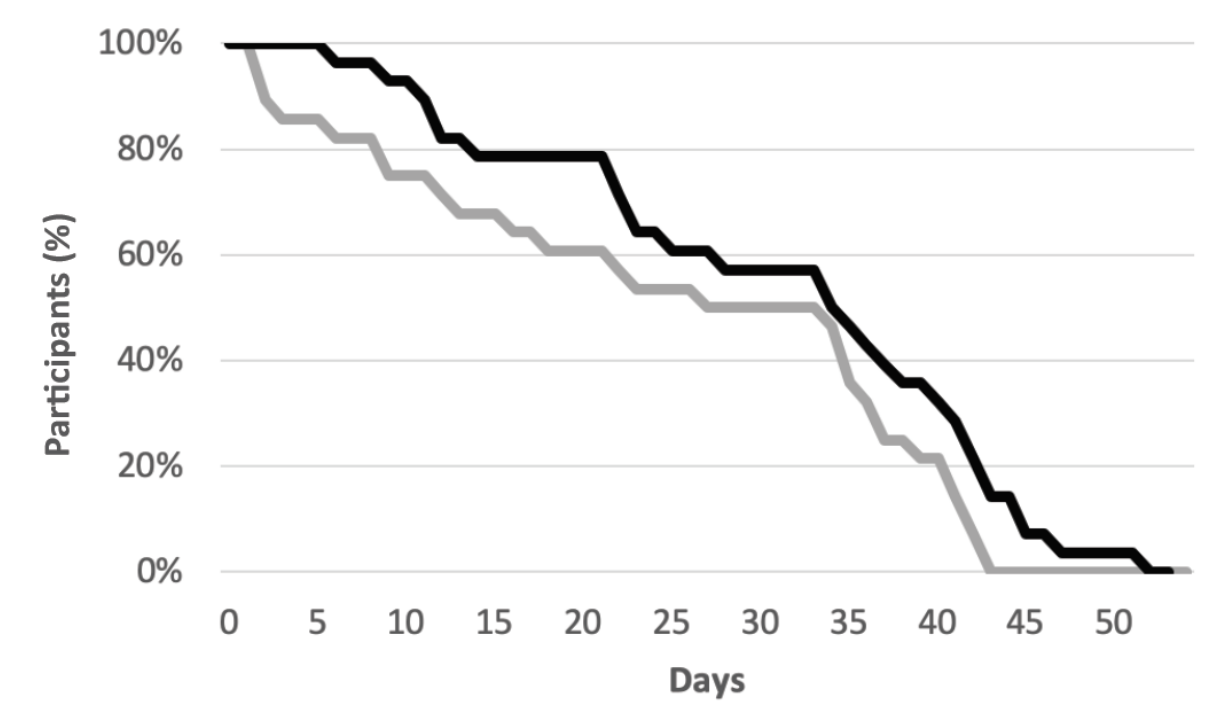
Figure 3. Patient engagement. Percentage of participants enrolled in the Intensive Outpatient Program clinic (black line) compared with the percentage of participants actively using their mobile app (grey line) by number of days in the